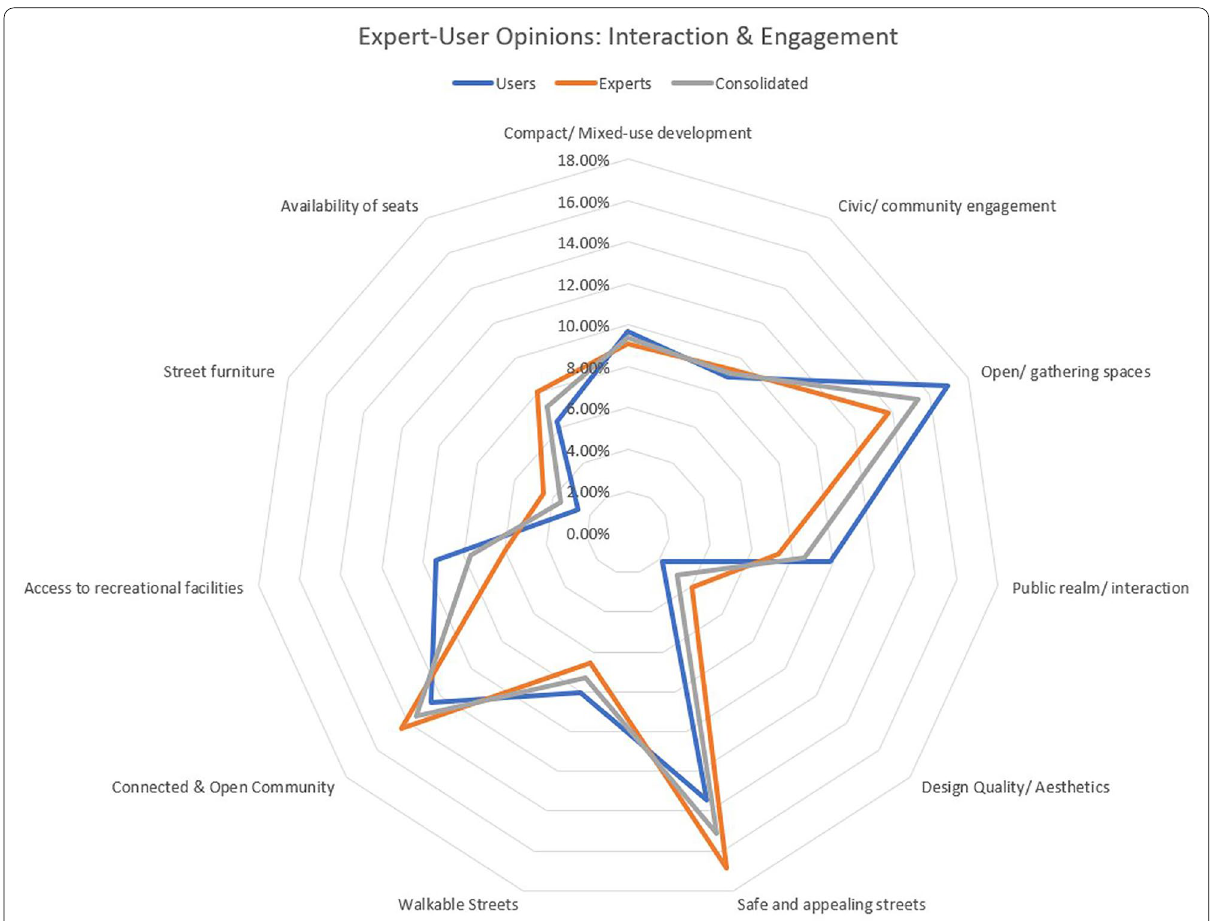
Fig. 6 Comparison between experts and users’ opinions—interaction and engagement